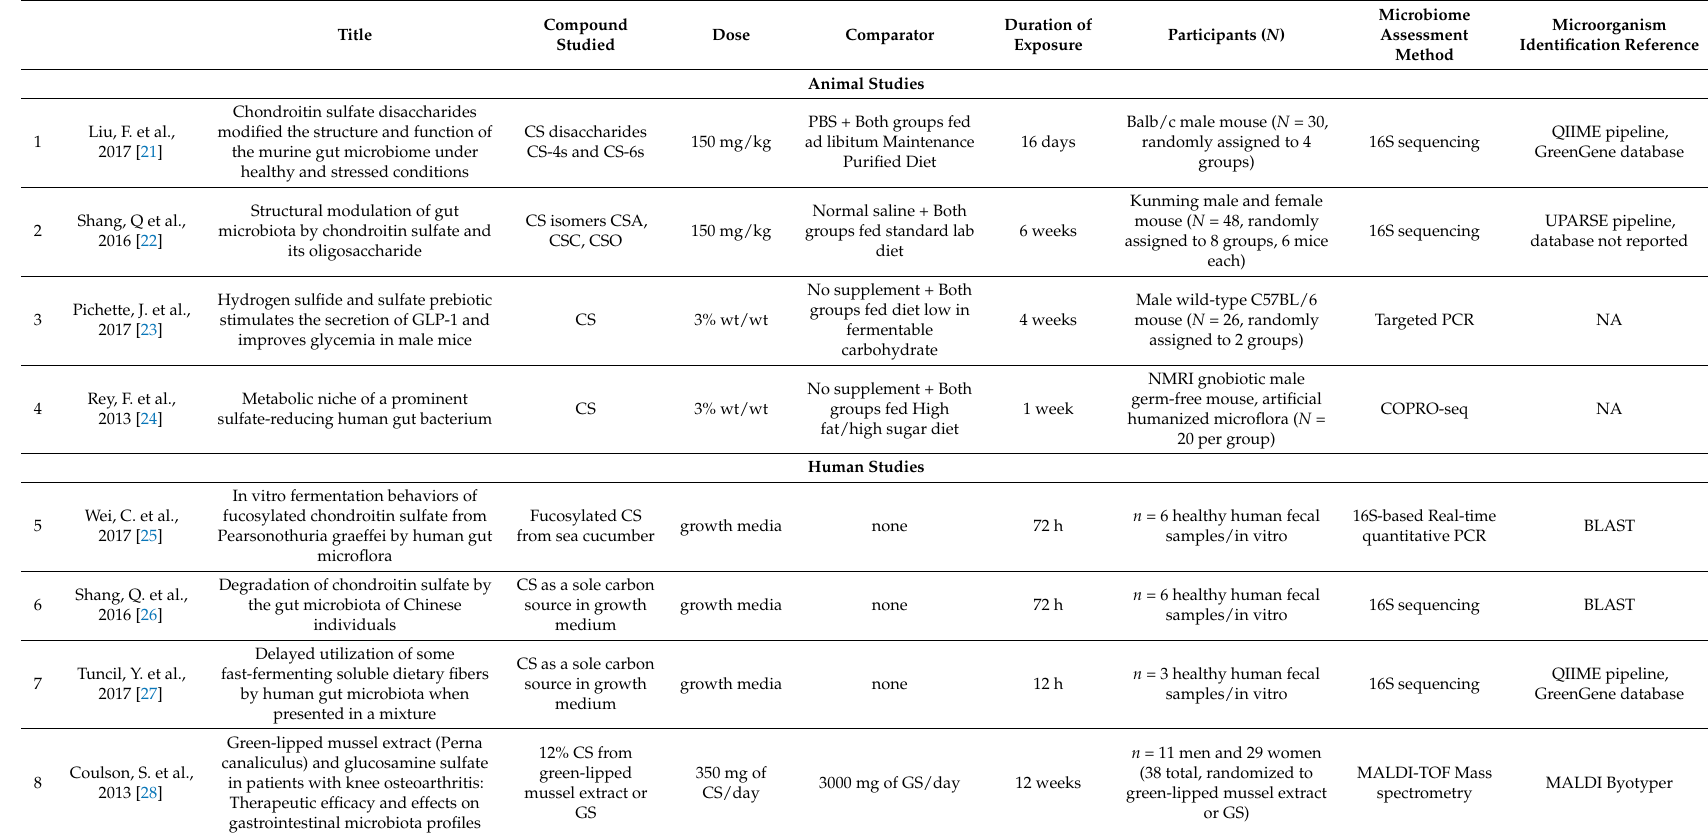
Table 1. Description of included